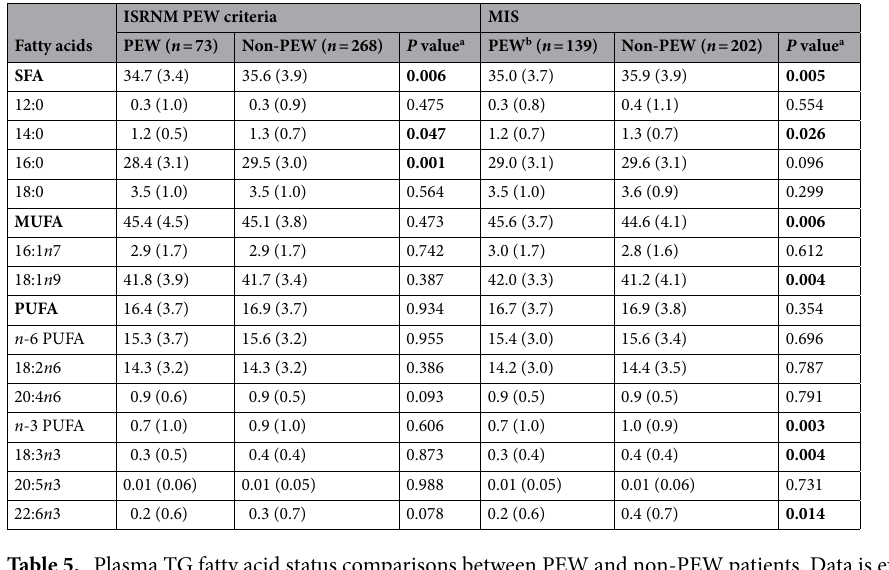
Table 5. Plasma TG fatty acid status comparisons between PEW and non-PEW patients. Data is expressed as median (interquartile range). a Mann–Whitney test. b PEW is defined as MIS ≥ 5. Values in bold indicate p -value < 0.05. ISRNM, International Society of Renal Nutrition and Metabolism; MIS, malnutrition inflammation score; MUFA, monounsaturated fatty acid; PEW, protein energy wasting; PUFA, polyunsaturated fatty acid; SFA, saturated fatty acid. FA nomenclature: 12:0 (lauric acid), 14:0 (myristic acid), 16:0 (palmitic acid), 16:1 n -7 (palmitoleic acid), 18:0 (stearic acid), 18:1 (oleic acid), 18:2 n 6 (linoleic acid), 18:3 n 3 (α-linolenic acid), 20:4 n 6 (arachidonic acid), 20:5 n 3 (eicosapentaenoic acid), 22:6 n 3 (docosahexaenoic